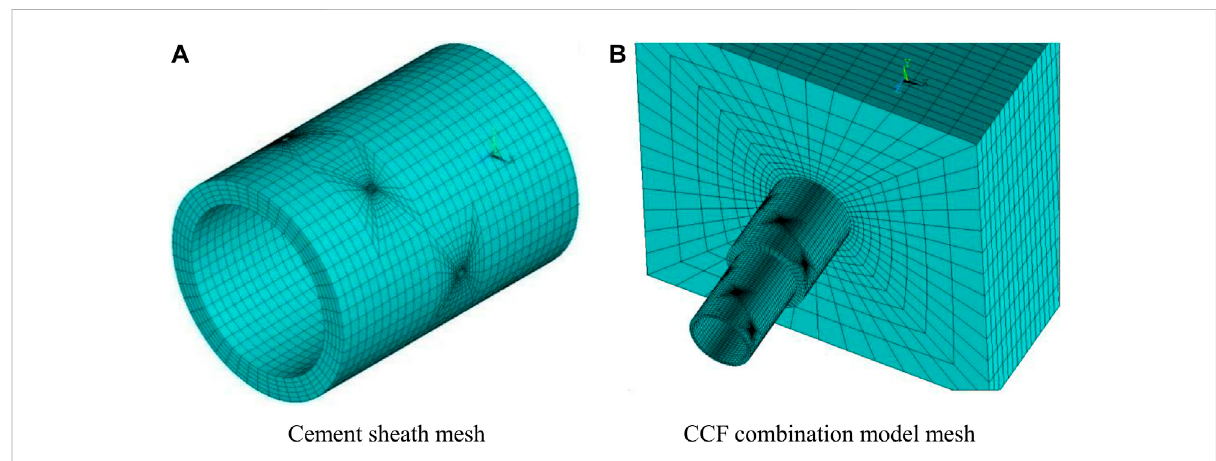
FIGURE 4 Finite element model mesh of CCF combination. (A) Cement sheath mesh. (B) CCF combination model